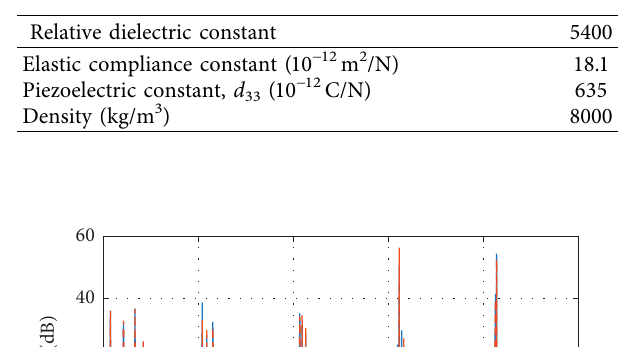
Table 2: Parameters of PZT.